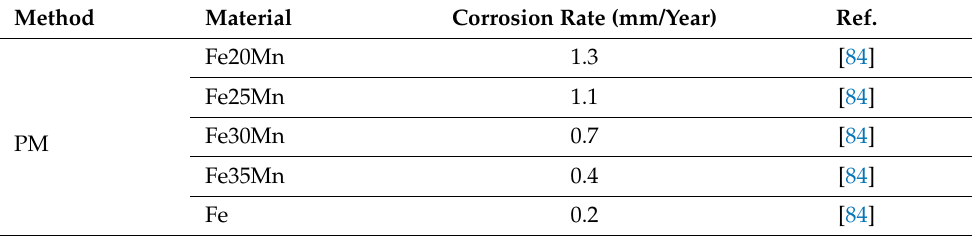
Table 7. Corrosion rates for Fe-based materials obtained by powder metallurgy. Method